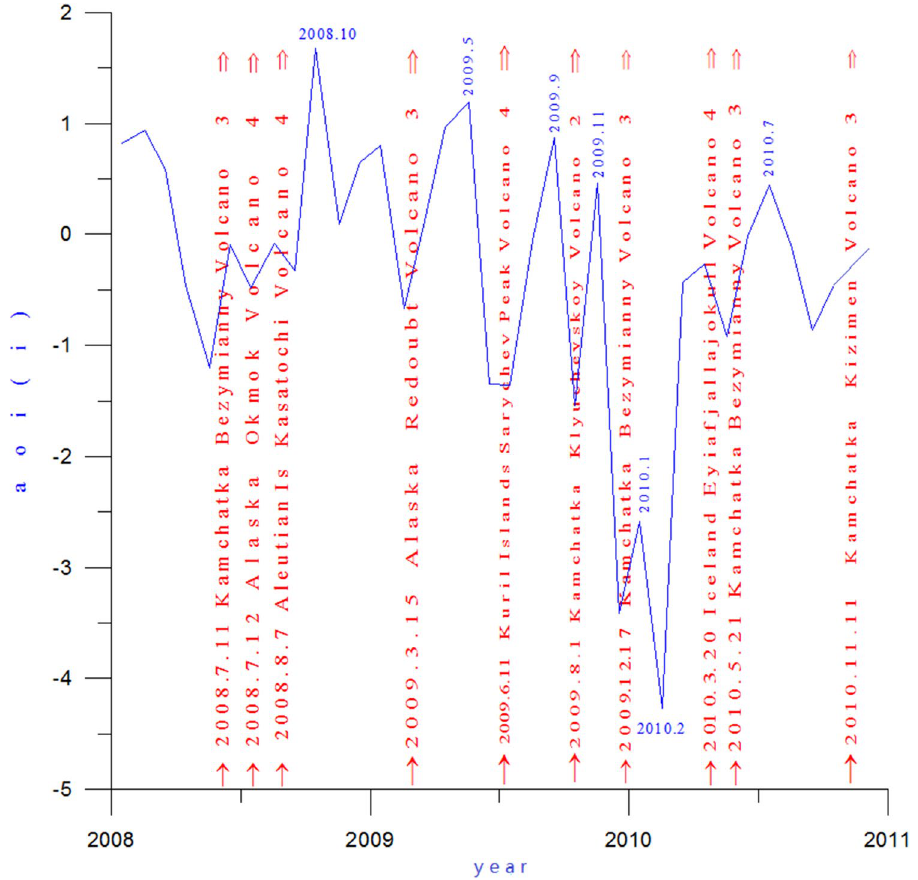
Figure 6. AOI (blue line) and volcanic activity (red arrows) from 2008 to